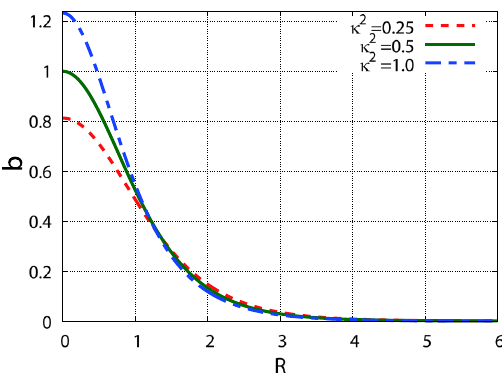
Fig. 5 (Leftpanel)thesolutions f and a ofthefieldequations(28)and (29) as functions of R for various values of the GL parameter defined = 1 , 1 √ in (32), κ := λ √ , and 1, with a unit winding number n = 1. 2 2 q 2 For convenience, we plot 1 − a in place of a . (Right panel) the corre-